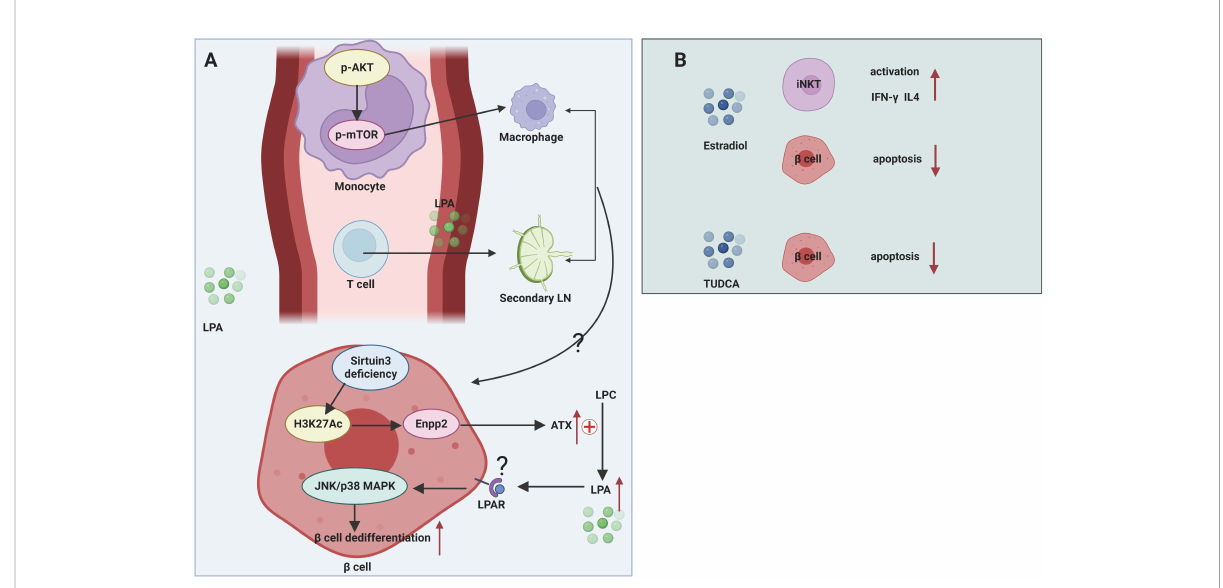
FIGURE 3 Mechanisms of glycerophospholipids and sterol lipids in T1DM. (A) LPA participates in pathogenic T cell migration from blood to secondary LNs. LPA can transform murine monocytes to macrophages by stimulating AKT/mTORC pathway. Sirtuin 3 de fi ciency of b cell facilitates the transcription of Enpp2 and subsequent high levels of ATX in extracellular environment. ATX converts LPC to LPA, which activates JNK/p38 MAPK pathway and facilitates b cell dedifferentiation and dysfunction. (B) Estradiol has a protective role in b cells by activating iNKT cells and mitigating b cell apoptosis. TUDCA can alleviate ER